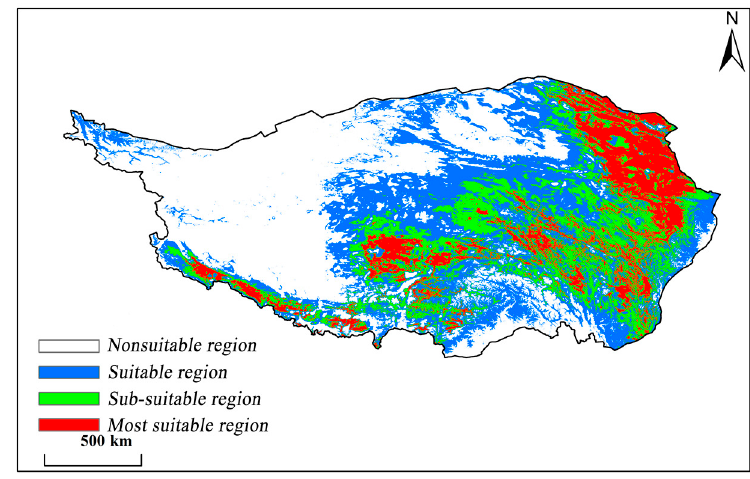
Figure 5. Potential distribution of Carex alatauensis based on MaxEnt. Table 3. Potential distribution area of Carex alatauensis.